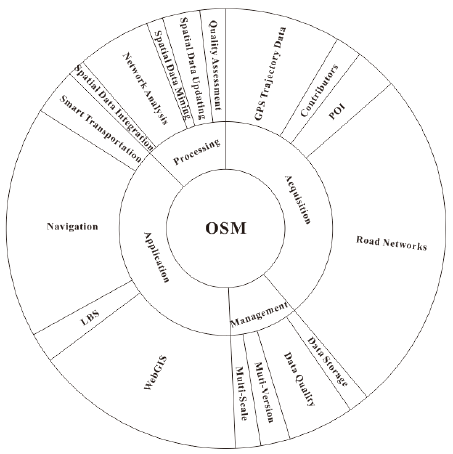
Figure1. The frequency of the keywords in the paper related OSM in China